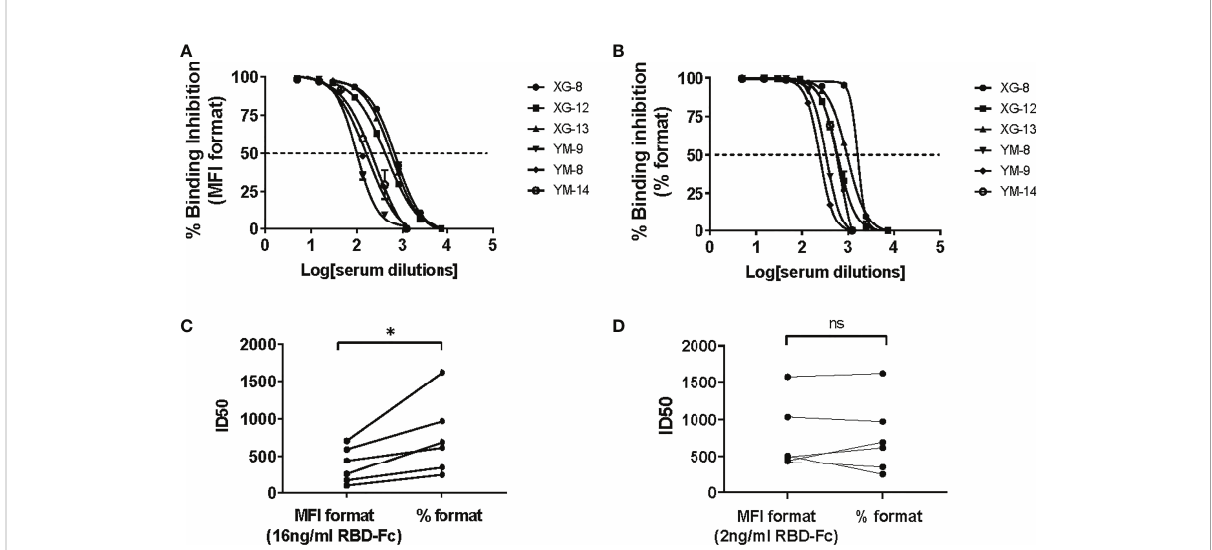
FIGURE 6 Comparison of ID50 values determined by the % formatted and the MFI formatted iACE2/RBD-Fc models. The sample dilution response inhibition curves of 3 convalescent plasma samples and 3 vaccine serum samples determined by the % formatted iACE2/RBD-Fc model using 2 ng/ml of RBD-Fc and the MFI formatted iACE2/RBD-Fc model using 16 ng/ml of RBD-Fc were shown in (A, B) , respectively. The ID50 values of the 6 samples determined by the % and MFI formatted iACE2/RBD-Fc models were compared and shown in (C) . The ID50 values of the 6 samples determined by the % formatted iACE2/RBD-Fc model and the MFI formatted iACE2/RBD-Fc model using 2 ng/ml of RBD-Fc for each assay were compared and shown in (D) . P values <0.05 and ≥ 0.05 are represented as * and ns,